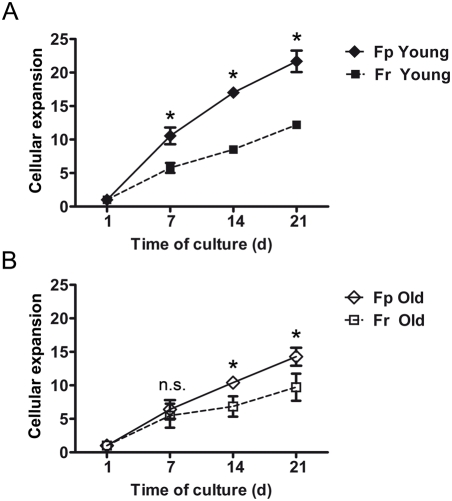
Age-related growth characteristics of Fp and Fr.Fp and Fr samples from 3 young (19 yr, 19 yr, and 26 yr) and 3 old donors (57 yr, 58 yr, and 67 yr) were cultured for 21 days. Cellular growth rate was estimated every 7 days after culture initiation. Data are expressed as cumulative expansion curves (means±SEM, n = 3 independent samples). (A) Comparison of growth rates of Fp and Fr from young donors. (B) Comparison of growth rates of Fp and Fr from old donors (*p<0.05; n.s. = not significant).